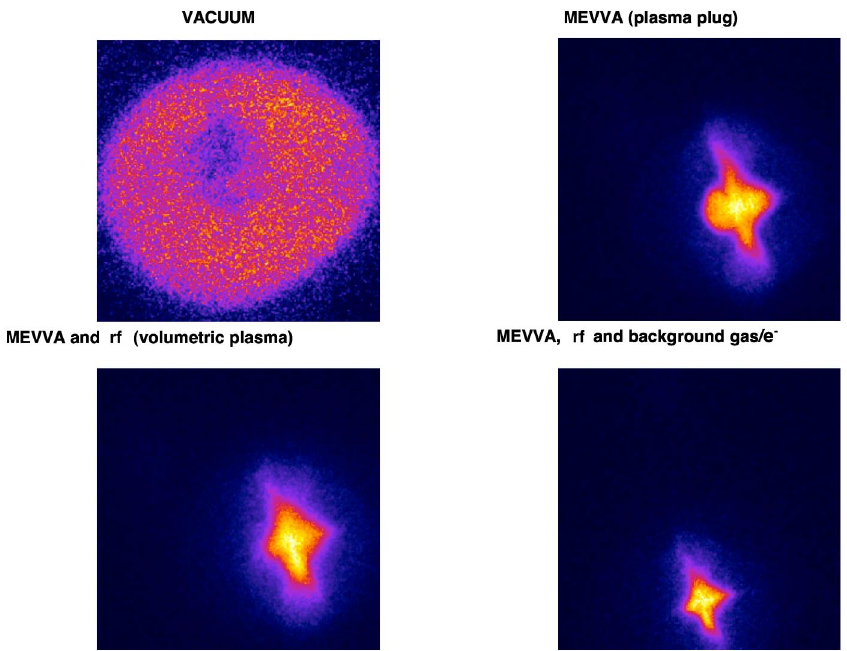
FIG. 40. (Color) NTX spot-size dependence on the neutralization mechanism. All image boxes are 4 cm (cid:5) 4 cm squares.